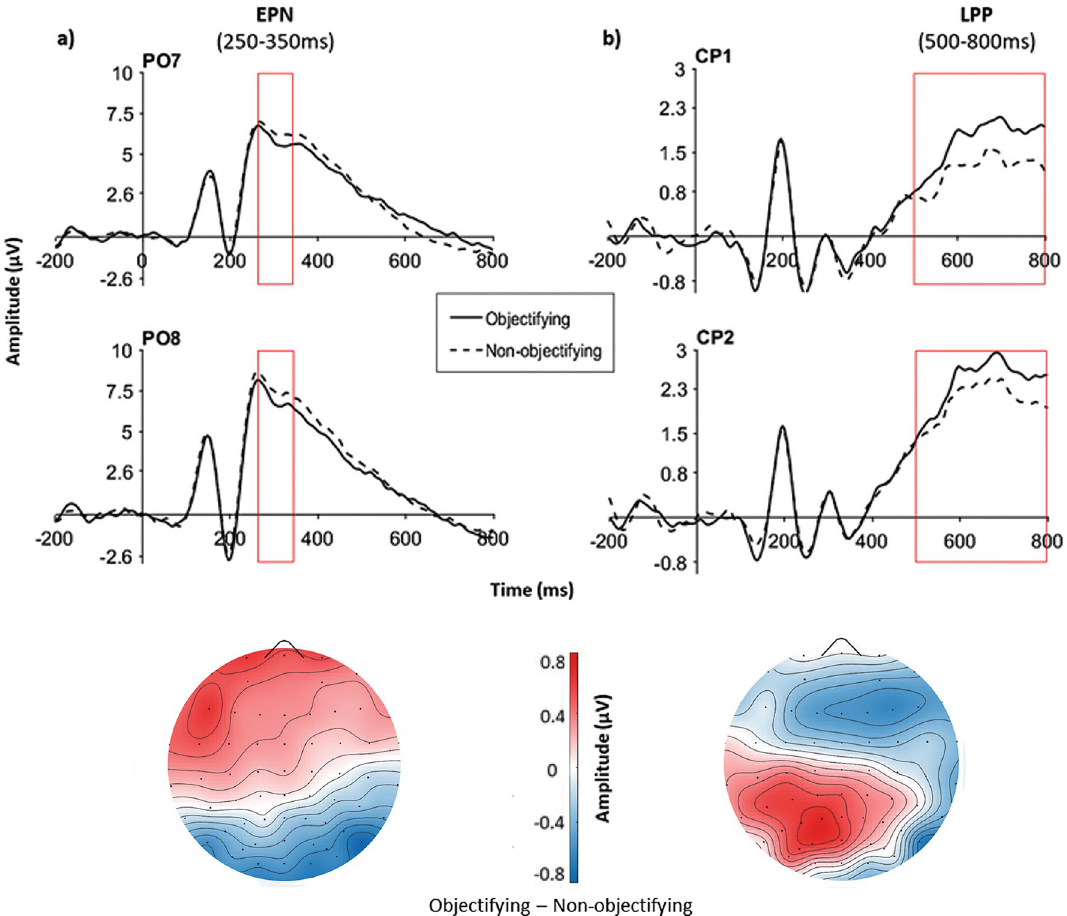
Figure 3. Waveforms and scalp distributions of the EPN and LPP. ( a ) EPN, and ( b ) LPP components. Waveforms (up of the panel) for the two components are plotted as a function of the objectifying and non- objectifying contexts in two representative electrodes: PO7-PO8 and CP1-CP2 for EPN and LPP, respectively. Scalp distribution (bottom of the panel) for the two components represents the difference between the objectifying and the non-objectifying conditions in the relevant time window of each